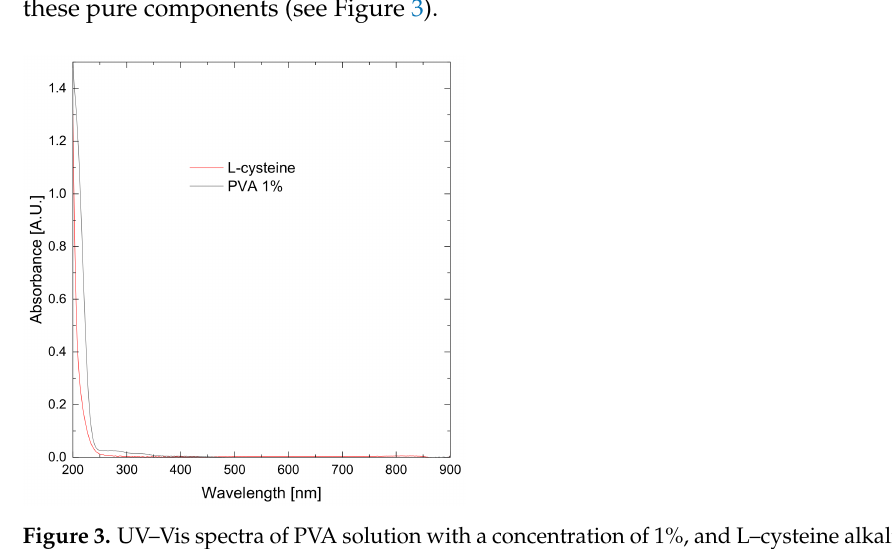
Figure 3. UV–Vis spectra of PVA solution with a concentration of 1%, and L–cysteine alkaline solution with a concentration of 0.1